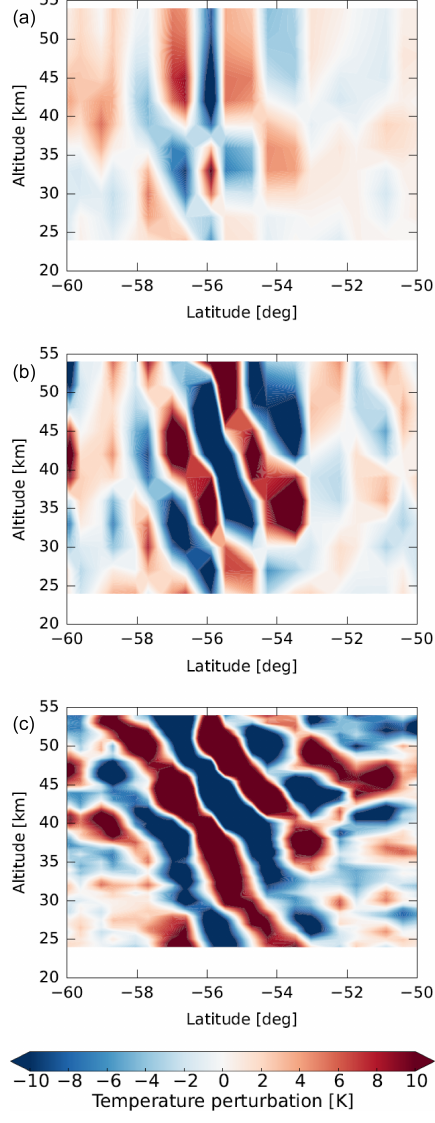
Figure 5. Vertical cross sections of temperature perturbations on 29 September 2006 at about 03:00UTC for a mountain wave event derived from the AIRS operational retrieval (a) , the AIRS high- resolution retrieval (b) , and HIRDLS (c)